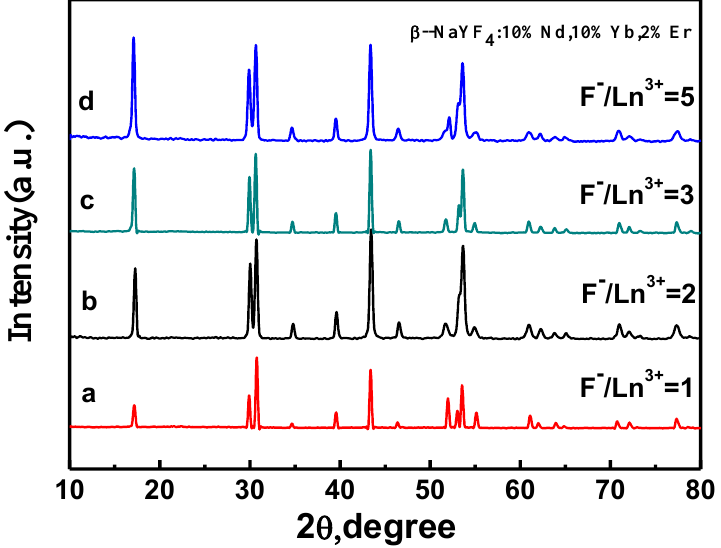
Figure 5. Typical FESEM images for the as-prepared NaYF microcrystals at different molar ratios of F − /Ln 3+ : ( a ) 1:1; ( b ) 2:1; ( c ) 3:1; and ( d ) 5:1 (Other synthetic parameters were kept identical, 180 °C, 24 h, OA/Ln 3+ = 20:1).